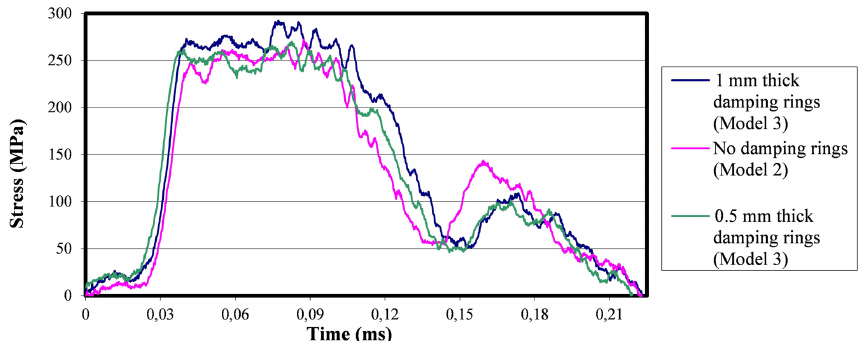
Figure 31. Incident stress-time curves pertinent to the actual experiment at 3.5 bar when using 1mm thick, 0.5mm thick, and no damping